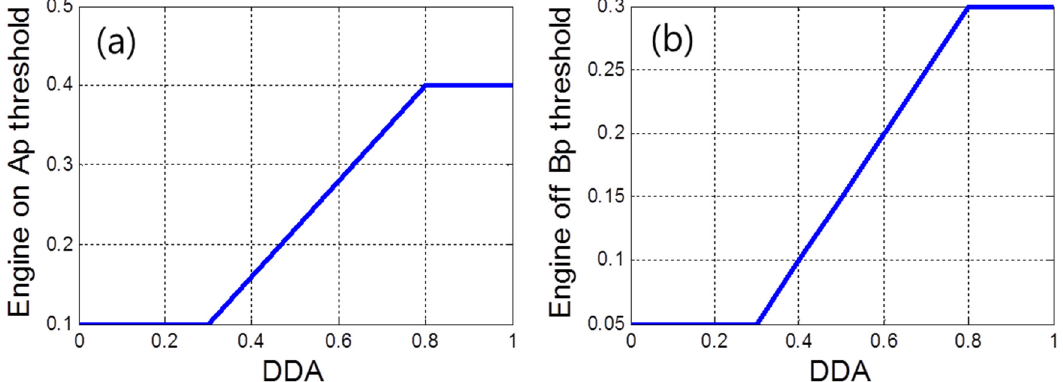
Figure 10. Weight factors of the engine on ( a ) and off ( b ) threshold